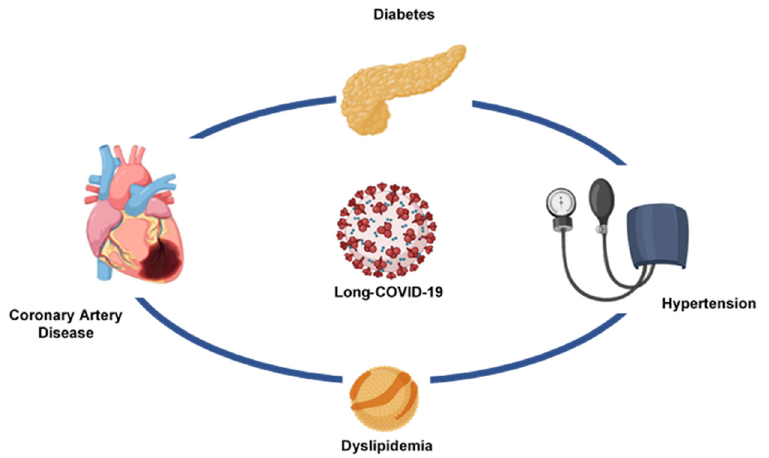
Figure 5. The cross-talk between coronary artery disease, diabetes, hypertension, dyslipidemia and Long-COVID-19.